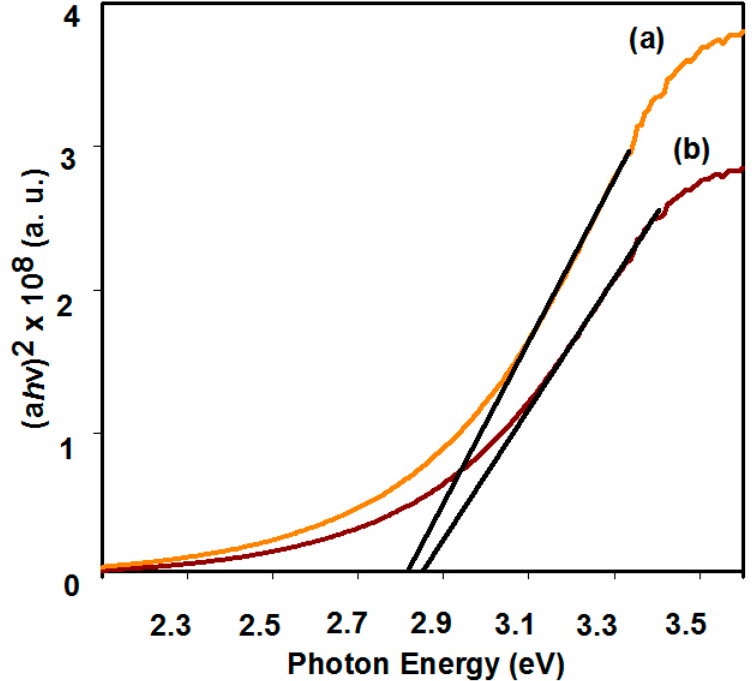
Figure 4. Plot of ( α h υ ) 2 versus photon energy ( h υ ) for Bi 2 WO 6 electrodes deposited by AACVD deposited at 500 °C, ( a ) hierarchical buckyball-like microsphere and ( b ) nanoplates.